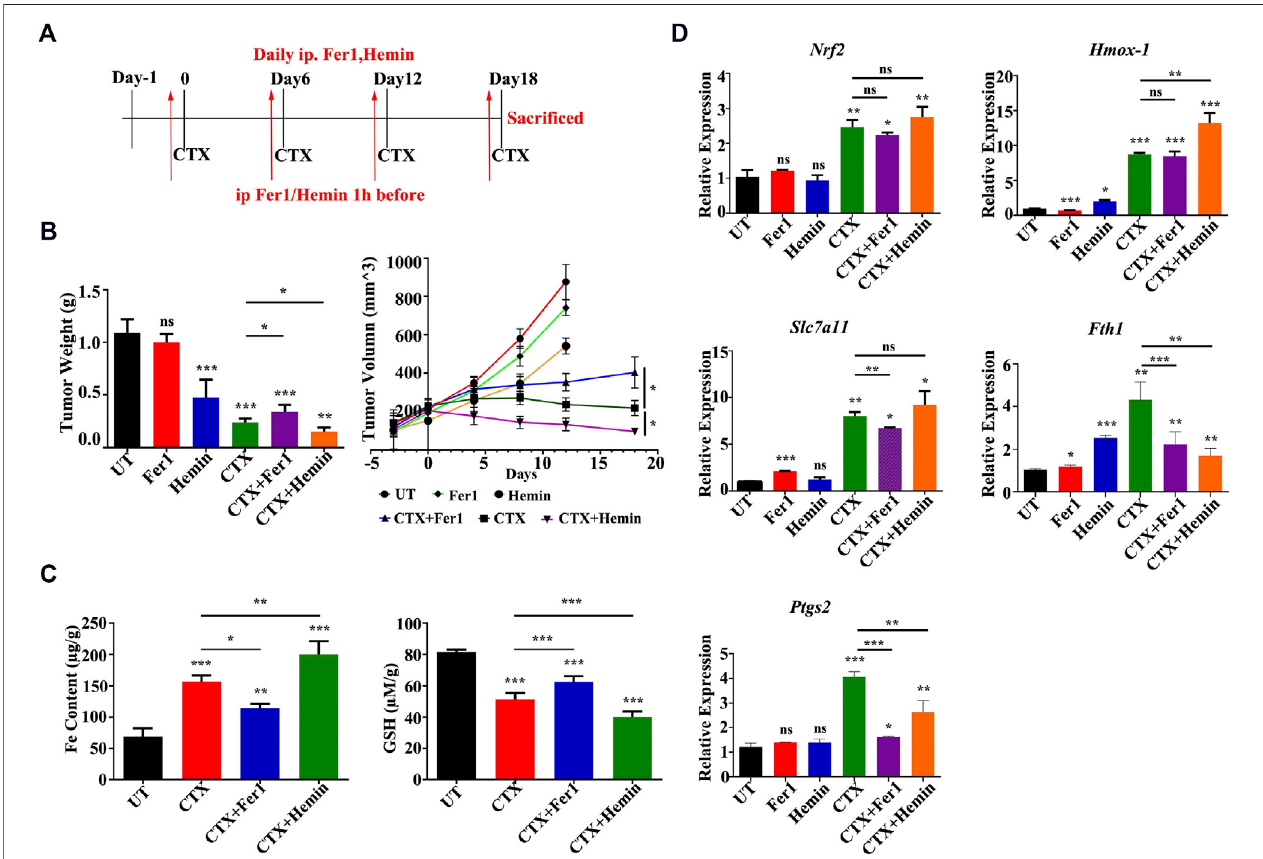
FIGURE 7 | An HMOX-1 agonist enhanced the chemotherapeutic effect of CTX by inducing ferroptosis. (A) The murine xenograft model was established and treatedasdescribedinthetext. (B) Tumorweightandvolumeofeachgroup( n =6 – 7)fortheindicatedtimes.Dataarepresentedasthemeans±SEM.ns,notsigni fi cant, * p < 0.05, ** p < 0.01, and *** p < 0.001 (one-way ANOVA analysis) for the indicated comparisons (C) Iron content and GSH levels in each group ( n = 6 – 7). Data are presented as the means ± SEM. * p < 0.05, ** p < 0.01, and *** p < 0.001 (one-way ANOVA analysis) for the indicated comparisons (D) Relative Nrf2, Hmox-1, Slc7a11, Fth1 and Ptgs2 mRNA levels in different groups ( n = 6 – 7). Data are presented as the means ± SEM; ns, not signi fi cant, * p < 0.05, ** p < 0.01, and *** p < 0.001 (one-way ANOVA analysis) for the indicated